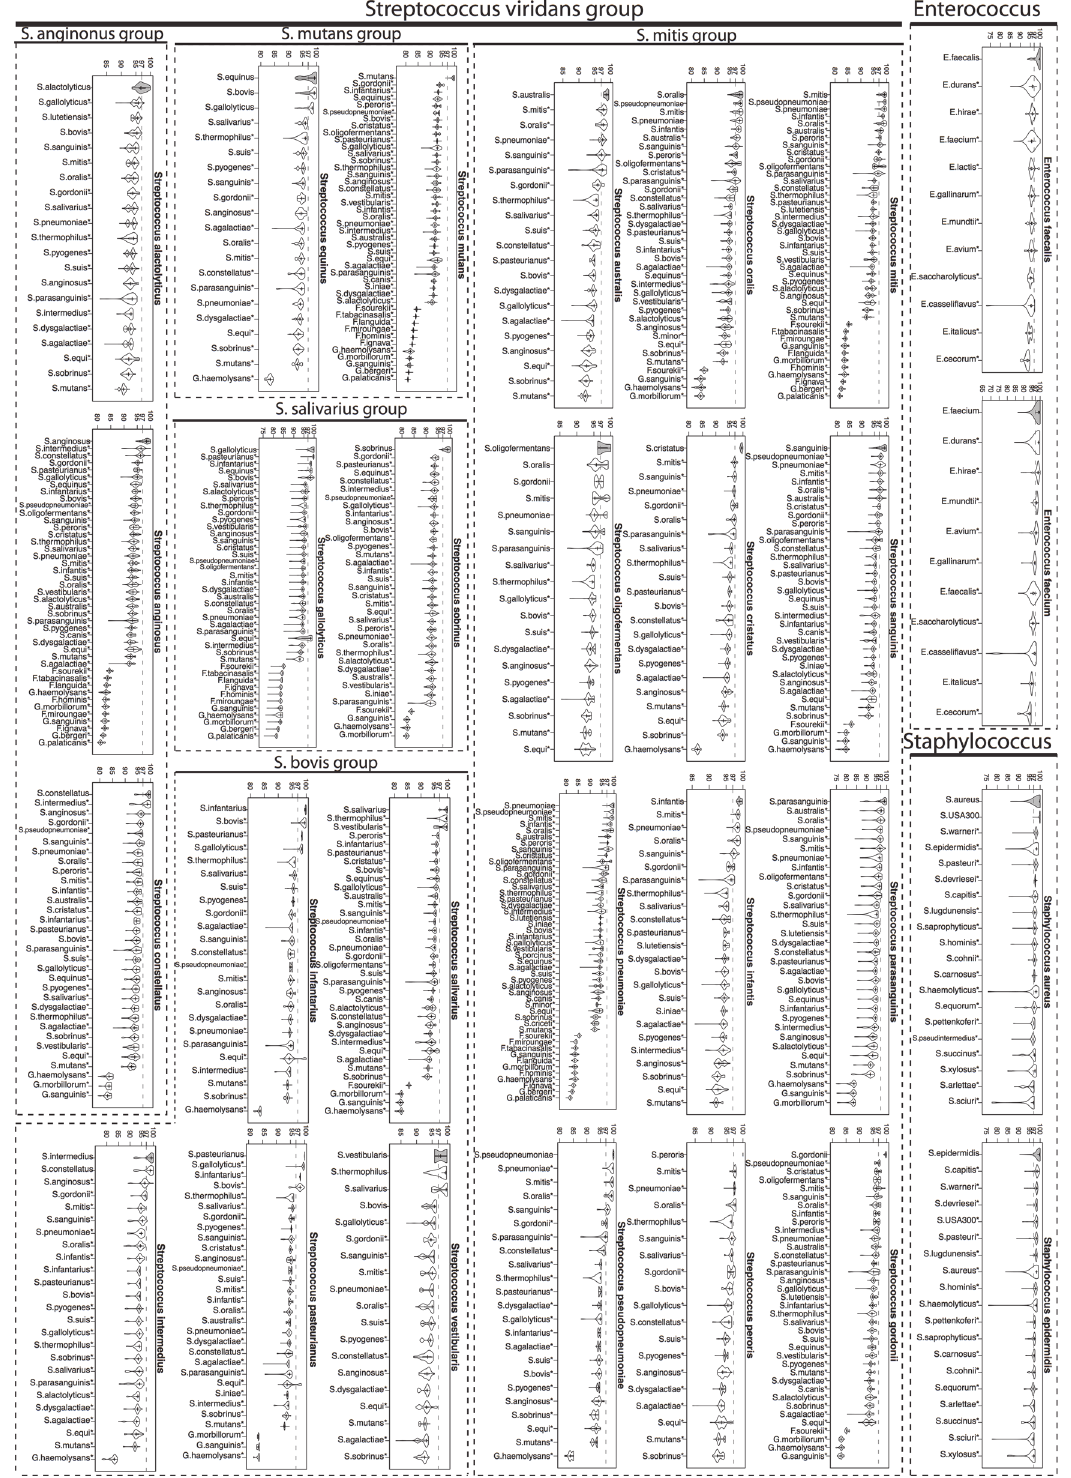
Fig 3. 16S rRNA percent identity within and between species (gram-positive bacteria). Distributions (shown as violin plots) of 16S rRNA percent identity (y-axis of each figure) of pairs of training set sequences belonging to the same (gray) and different species for select gram-positive bacteria. 97% identity, the traditional species level cutoff, has been marked for reference. Species for which sequence variability between sequences from the same species was significantly higher than between those from different species are marked with a * (Wilcoxon test one-sided p-value < 0.0001).